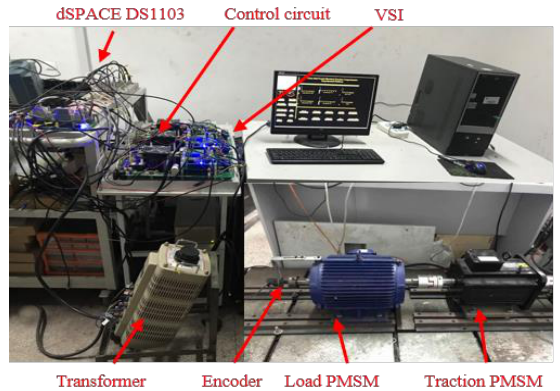
Figure 7. Experimental platform. Note: VSI = voltage source inverter.